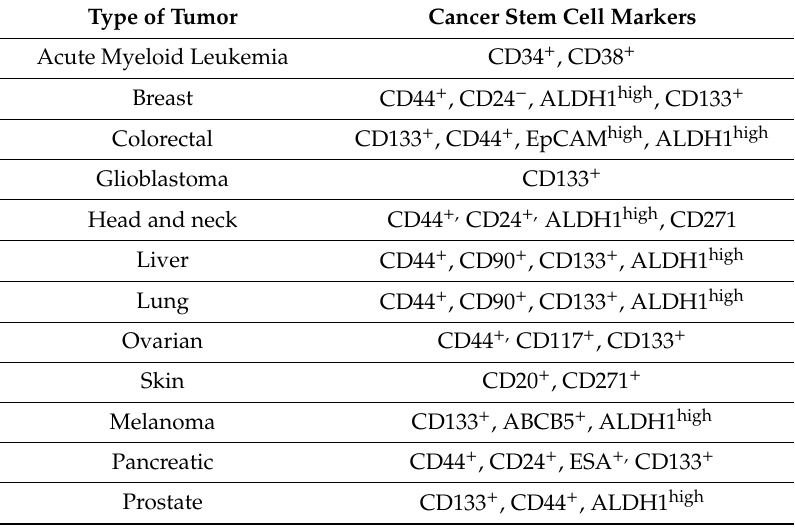
Table 2. CSCs markers in di ff erent